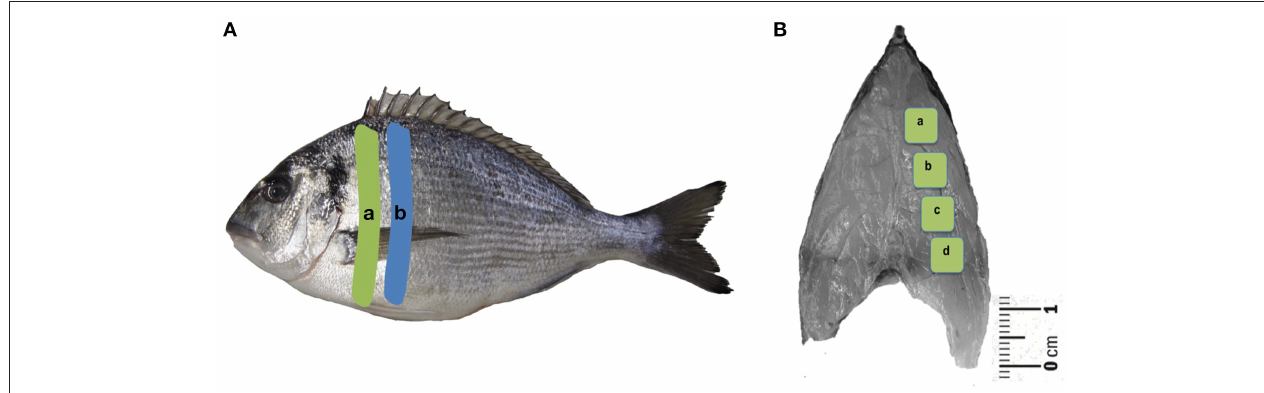
FIGURE 1 | (A) Filet sampling area for histology parameters (a) and for molecular biology analysis (b) and (B) dorsal areas (a–d) selected for muscle cellularity